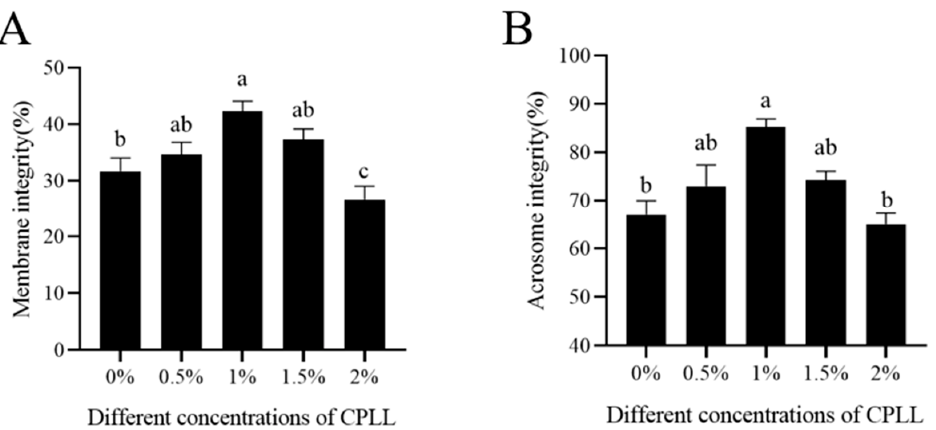
Figure 1. Effects of CPLL supplementation at 0% to 2.0% level to the freezing medium on post-thaw goat sperm membrane integrity ( A ) and acrosome integrity ( B ). Values are specified as mean ± standard deviation (SD). Columns with different lowercase letters differ significantly ( p < 0.05).